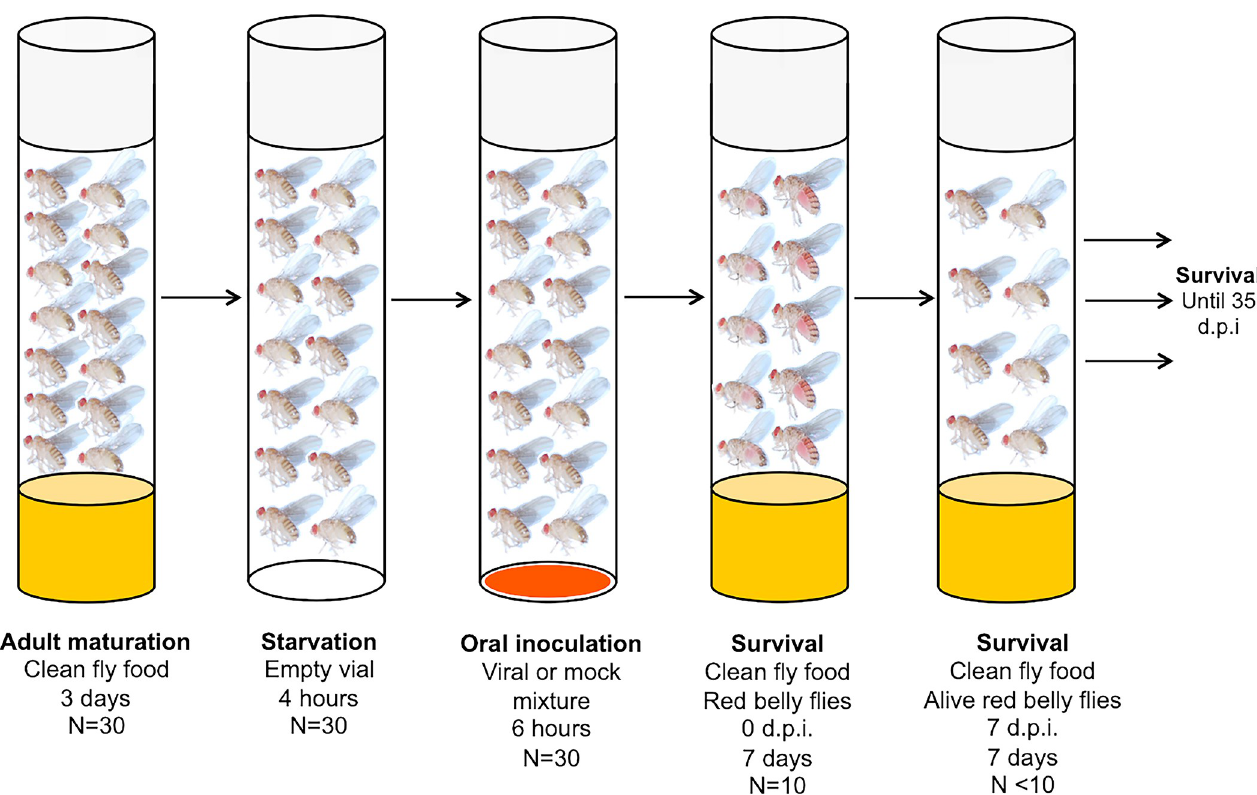
Fig 1. Diagram of the oral DCV or DXV infection protocol in Drosophila melanogaster . First, 15 males and 15 females were placed in a clean vial containing fly food for 3 days to reach complete maturation. Flies were next transferred into an empty vial to starve for 4 hours. Flies were then placed into new vials for 6 hours, where flies fed from either a virus or mock mixture that contained red dye. After this inoculation period, 10 flies (5 males and 5 females) showing a red belly, were transferred into a new vial containing food (without any pathogen). Finally, the number of dead and alive flies was scored on a daily basis over a period of 35 days and alive flies were transferred into clean vials containing fly food every 7